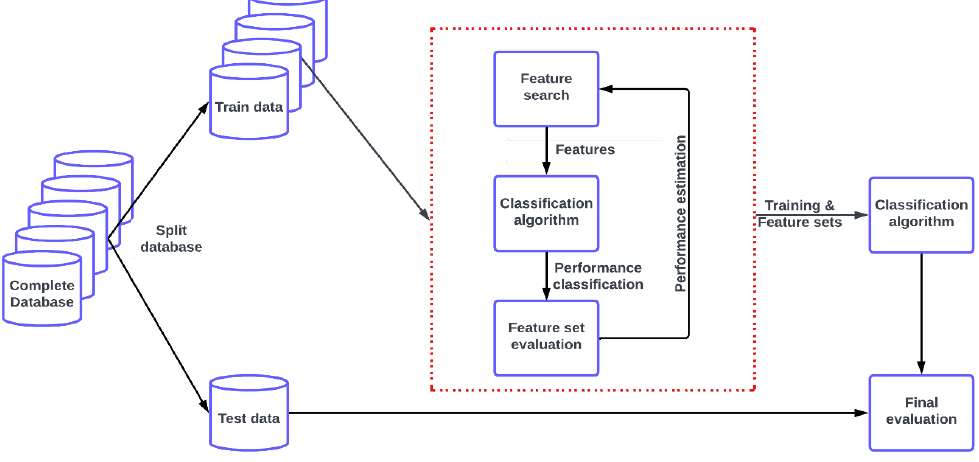
Figure 1. Wrapper feature selection